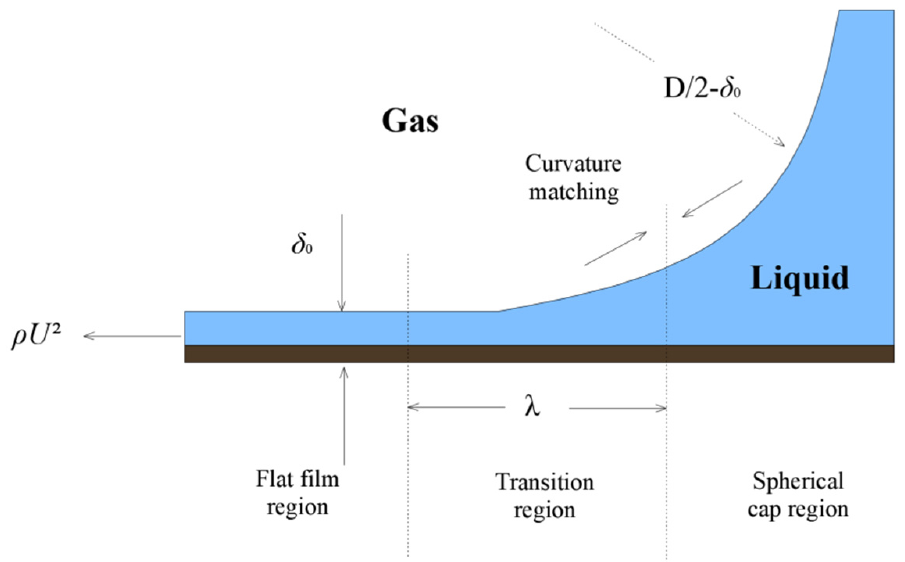
Figure 5. The force balance diagram for the bubble’s head, transition, and smooth zone. Due to the random nature of the gas–liquid two-phase flow, the lengths of both bubbles and liquid slugs were not identical. It was assumed that all bubbles had the same length and were multiples of the diameter of the circular tube. Similarly, it was assumed that all liquid slugs were of the same length. The object of calculation and analysis was a cell consisting of a bubble and a slug. Based on the theory of multiphase media, a mathematical model of slug flow in a circular tube section in axisymmetric form was established. Firstly, it can be assumed that the computational domain of a single fluid based on the mass conservation equation can be obtained as the continuity equation in column coordinates ( x , r , θ ) [28]